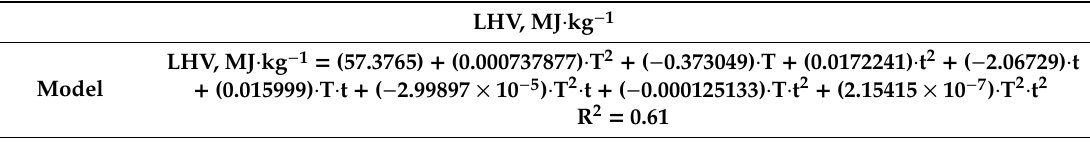
Table A10. The statistical parameters of polynomial regression analysis of the influence of SS torrefaction temperature and residence time on LHV of the biochars.